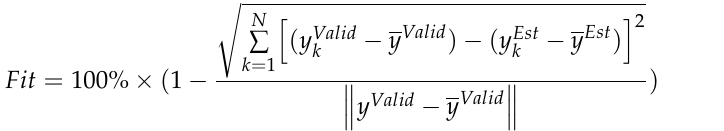
Figure 20. Estimated inputs to the rotor/RAMB model for validation. Table 1. Fit values between validation data and responses of Hammerstein – Wiener model, NARX model, and NARMAX model.